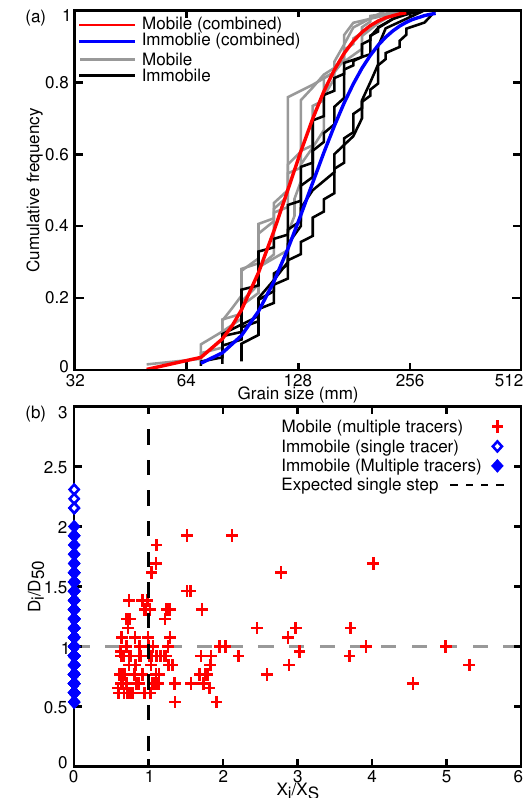
Figure 11. (a) CDFs for tracer grain size (mm) for single floods separated by whether the tracer moved (light-gray lines) or re- mained immobile (black lines). The red and blue lines represent lognormal functions fit to the combined mobile and immobile trac- ers, respectively. (b) Tracer grain size normalized by D 50 against tracer travel distance normalized by the expected step length ( X s ) from Eq. (1). Red crosses represent mobile tracers for all single floods ( n = 108) near the threshold of motion ( τ ∗ < 0.045), and blue diamonds represent tracers that did not experience movement ( n = 269) (solid diamonds represent multiple tracers plotted on top of each other). The dashed black line denotes the expected single step